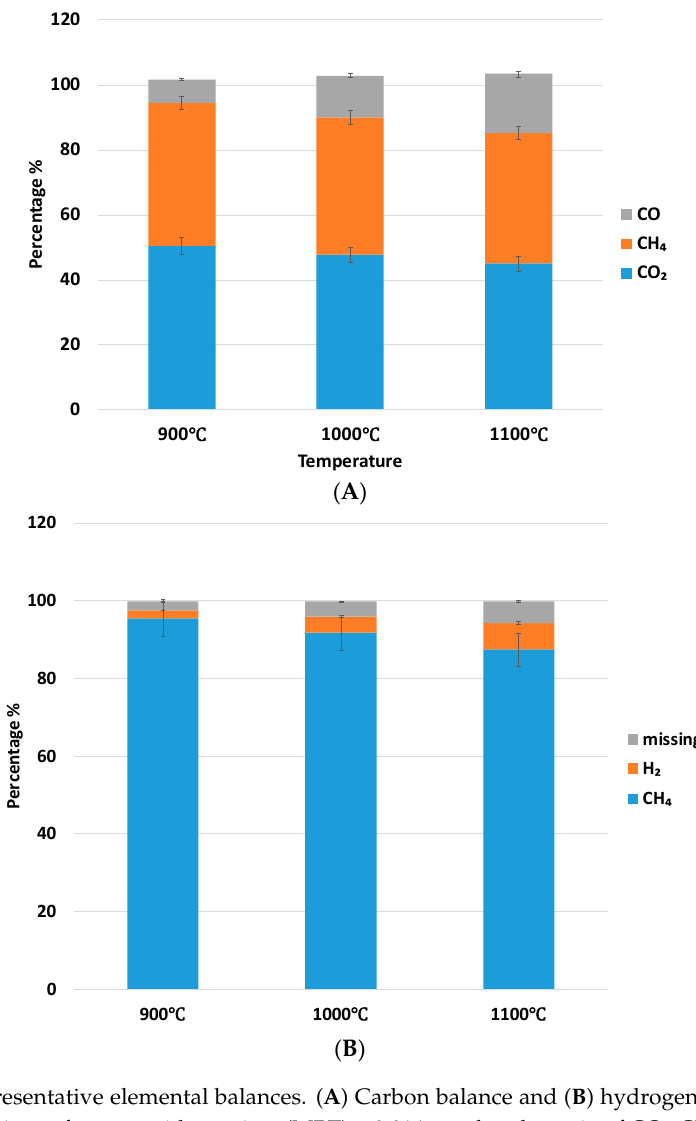
Figure 7. Representative elemental balances. ( A ) Carbon balance and ( B ) hydrogen balance for the reaction conditions of mean residence time (MRT) = 0.014 s and molar ratio of CO ₂ :CH ₄ equal to 1:1.